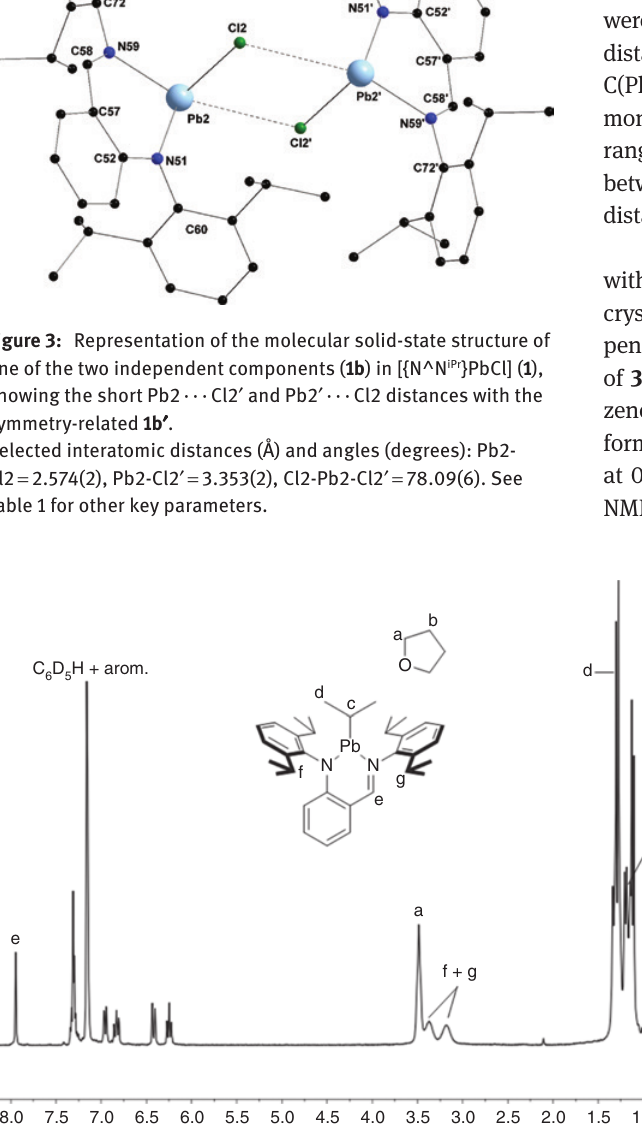
Figure 4: 1 H NMR spectrum (benzene- d † Silicone grease; ‡ residual